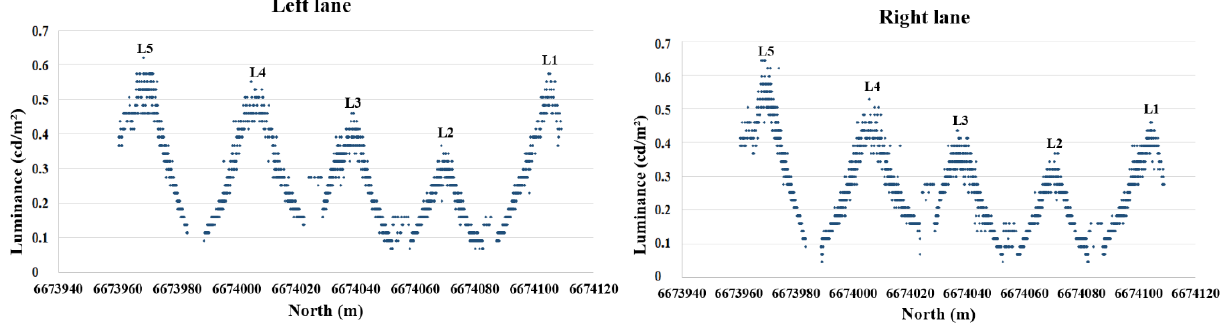
Figure 6. The ( left) and ( right) lane luminance values in the longitudinal direction along the centreline of each lane. The position of the lamps (L1–L5) are marked above the corresponding luminance peaks.